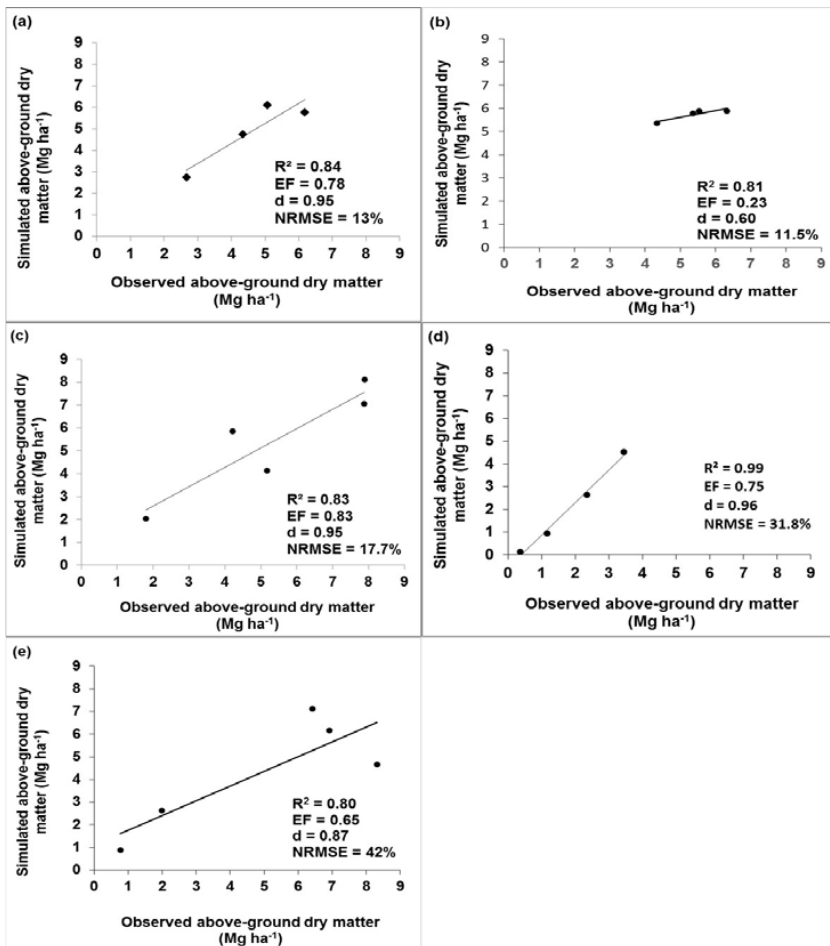
Figure 10. Evaluation of simulated and observed aboveground dry matter of ( a ) maize in VF1 in